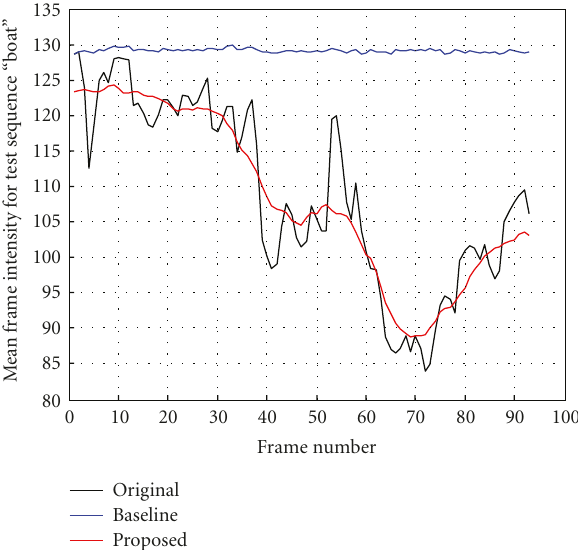
Figure 2: Comparison of mean frame intensity as a function of time between the original, the baseline scheme [7, 8] and the proposed